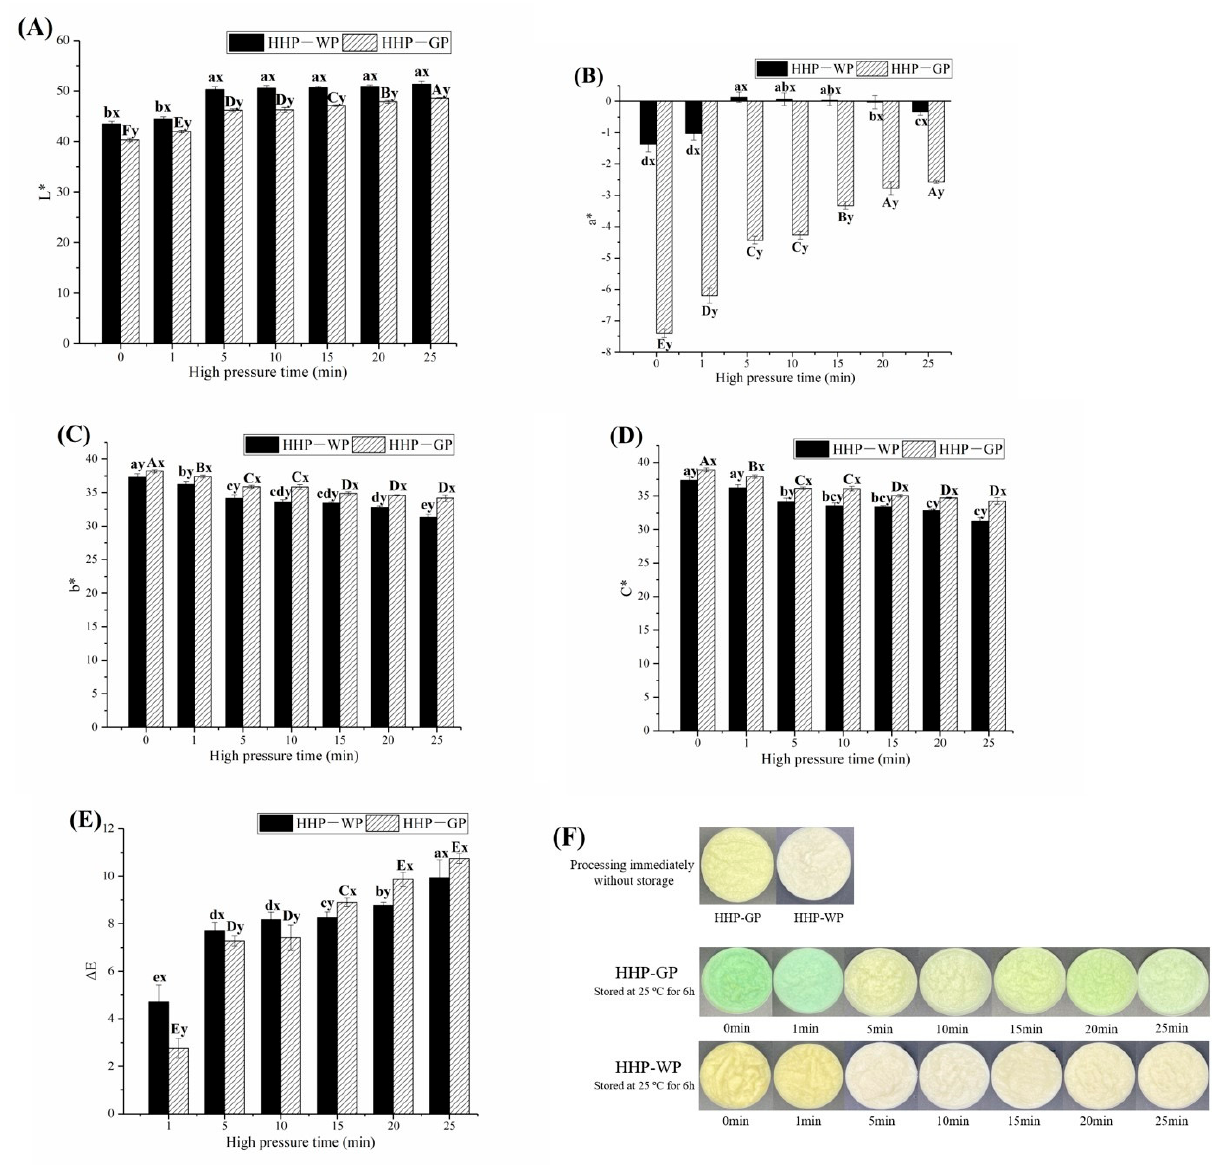
Figure 3. Effect of HHP time on garlic paste color indexes and appearances. ( A ) L*, ( B ) a*, ( C ) b*, ( D ) color chroma, C*, ( E ) total color difference, ∆ E, ( F ) color appearance. “a − e” and “A − E” mean within HHP-WP and HHP-GP group, respectively, while different letters indicate a significant difference ( p < 0.05). “x-y” with different letters indicates a significant difference ( p ≥ 0.05) between HHP-WP and HHP-GP under the same HHP conditions.